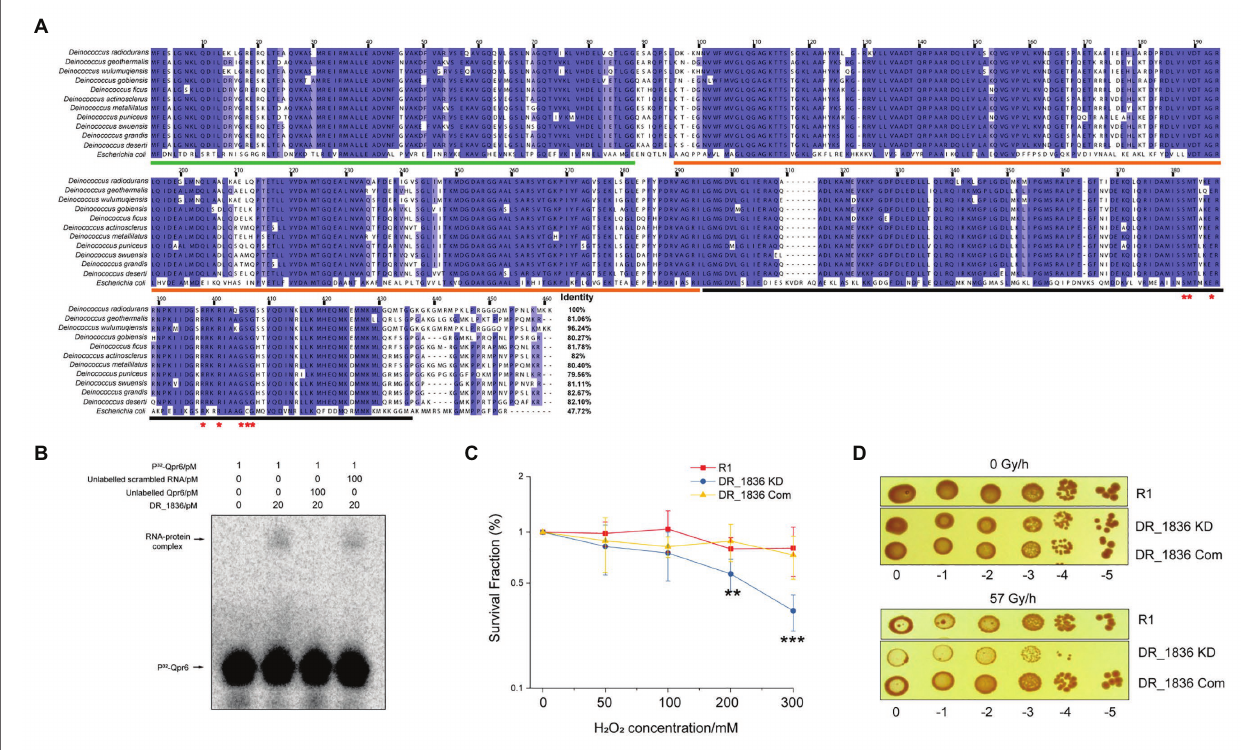
FIGURE 3 | Characterization of DR_1836 as the SRP protein in D. radiodurans . (A) Sequence alignment of SRP proteins from different Deinococcus species and E. coli , with the numbering consistent with the SRP protein of D. radiodurans R1 (DR_1836). Residues with ≥ 90% conservation indicated are in blue, and residues with ≥ 70% conservation are indicated in light blue. Invariant residues in the RNA binding region of the protein are indicated with red asterisks. The residues of N domain, G domain, and M domain are underlined in green, orange, and black, respectively. (B) Electrophoretic mobility shift assay (EMSA) to detect the direct interaction between Qpr6 and DR_1836 protein. One picomolar of radiolabeled Qpr6 ( 32 P-Qpr6) was incubated with 20 pM of purified DR_1836 protein in each reaction. To test the specificity of the Qpr6-DR_1836 interaction, 100-fold excess (100 pM) of unlabeled Qpr6 or scrambled RNA were added to the reactions. The concentration of RNA/protein used in each reaction is indicated on the top of the Figure. (C) Survival of R1, DR_1836 KD and DR_1836 Com under H 2 O 2 stress. Error bars indicate standard errors of the means ( n = 3). ** p ≤ 0.01 and *** p ≤ 0.001 were considered as significant using the Student t -test. (D) Growth of R1, DR_1836 KD, and DR_1836 Com under 0 and 57 Gy/h radiation ( γ -ray) for 6